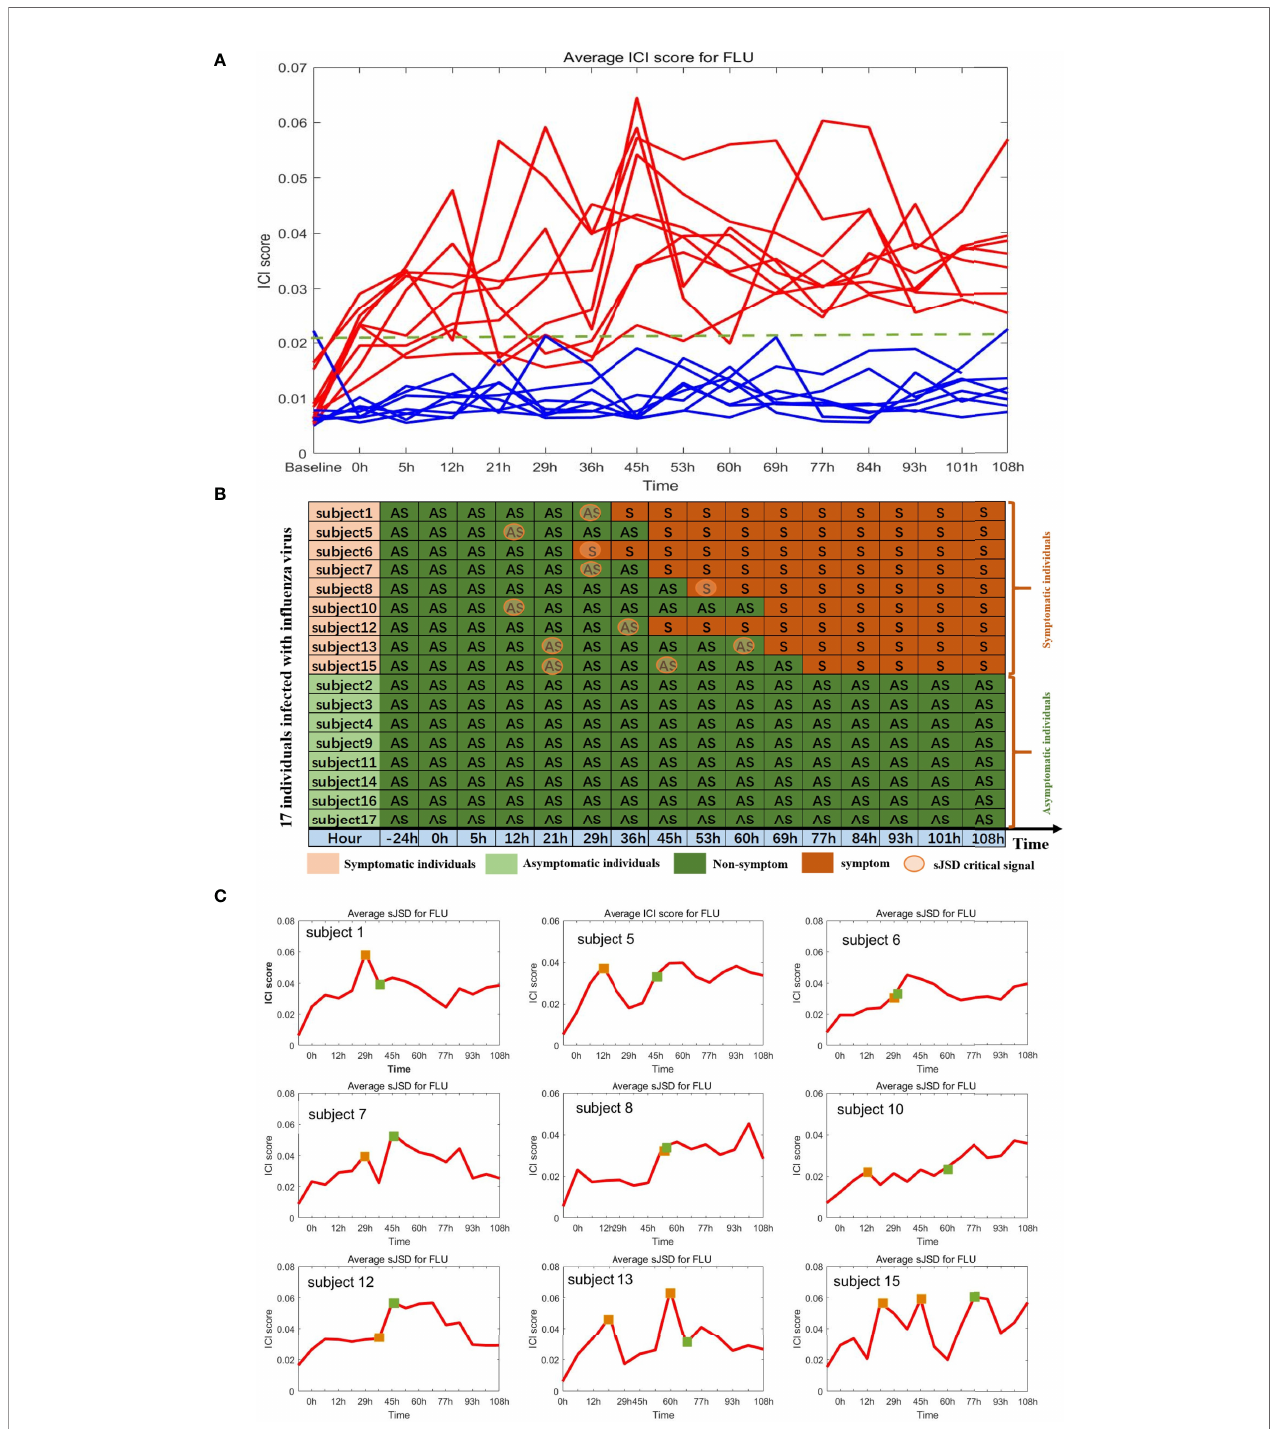
FIGURE 6 | Identi fi cation of critical state of in fl uenza based on sJSD. (A) The ICI score curve for 17 subjects. The red curve represents the average ICI scores for 9 symptomatic subjects. The blue curve represents the average ICI score for eight asymptomatic subjects. (B) Summarized predicted results. For each symptomatic individual, the ICI scores successfully indicate the impending fl u symptoms. While for asymptomatic individuals, there were no wrong warning signals. (C) The curve of average ICI scores for nine symptomatic individuals. The green squares represent the initial time when fl u symptoms appear (clinically observed), and the orange squares represent the critical state identi fi ed by the ICI